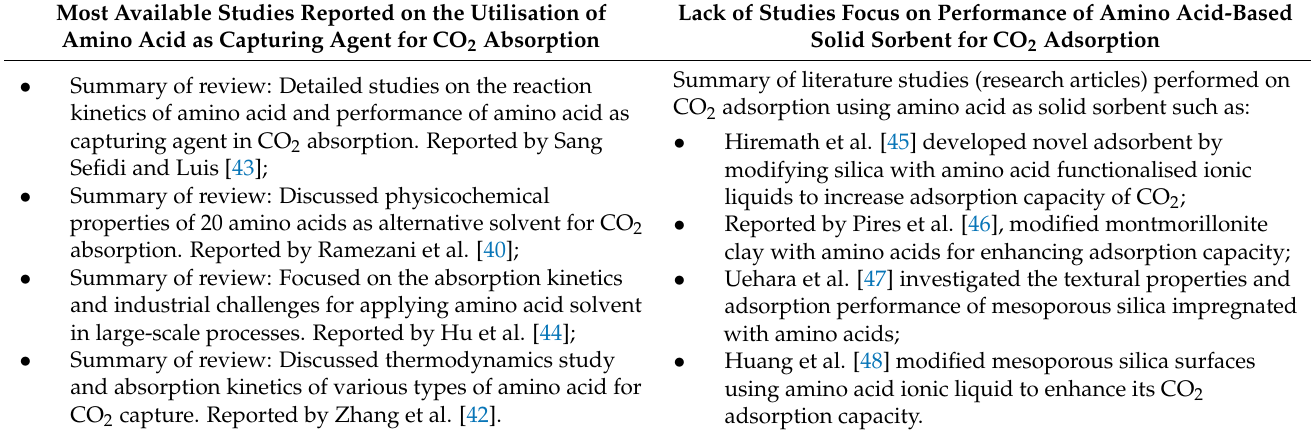
Table 2. Studies reported on the utilisation of amino acid for CO 2 absorption and adsorption. Most Available Studies Reported on the Utilisation of Lack of Studies Focus on Performance of Amino Acid-Based Amino Acid as Capturing Agent for CO 2 Absorption Solid Sorbent for CO 2